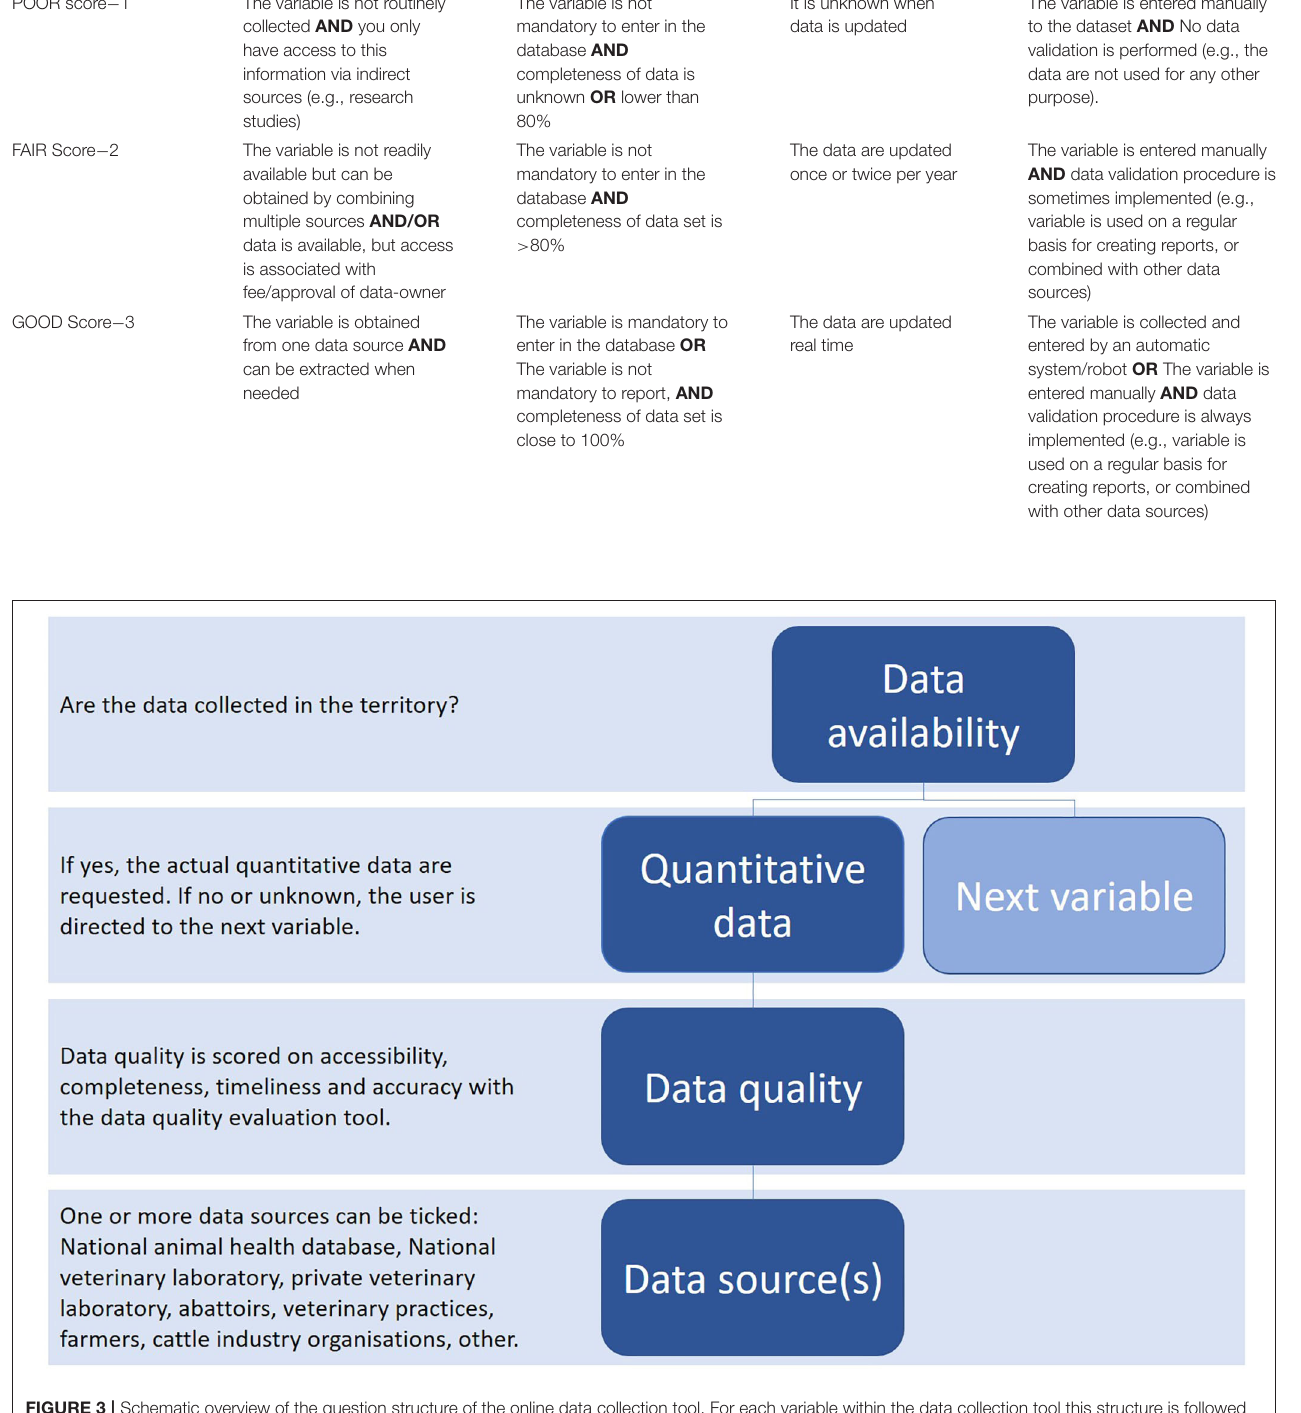
Frontiers in Veterinary Science |